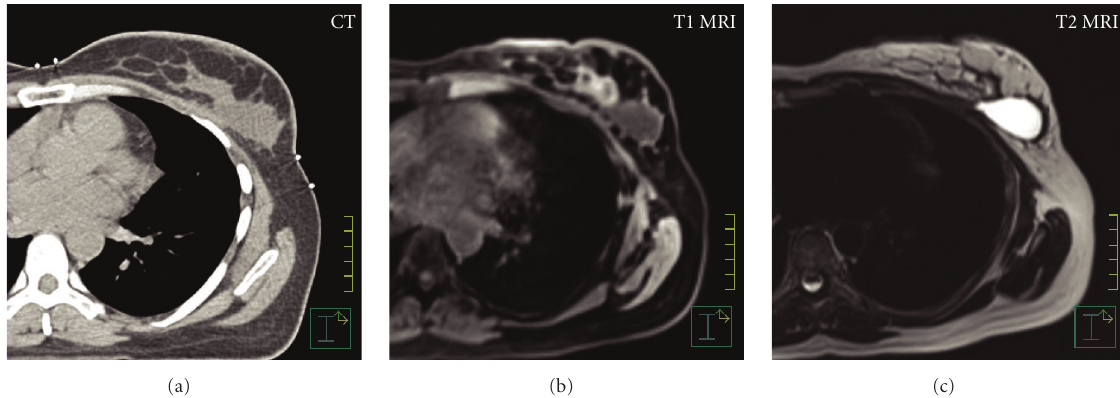
Figure 1: Comparison of imaging modalities. (a) CT shows homogeneous gray area. Borders are distinct laterally. Medially, the borders between lumpectomy cavity and breast parenchyma and chest wall are poorly defined. CVS 3. (b) T1 MRI, noncontrast, shows cavity with fairly well-defined borders, some rim enhancement. CVS 4. (c) T2 MRI noncontrast shows hyperintense signal consistent with seroma, distinct margins. CVS 5.